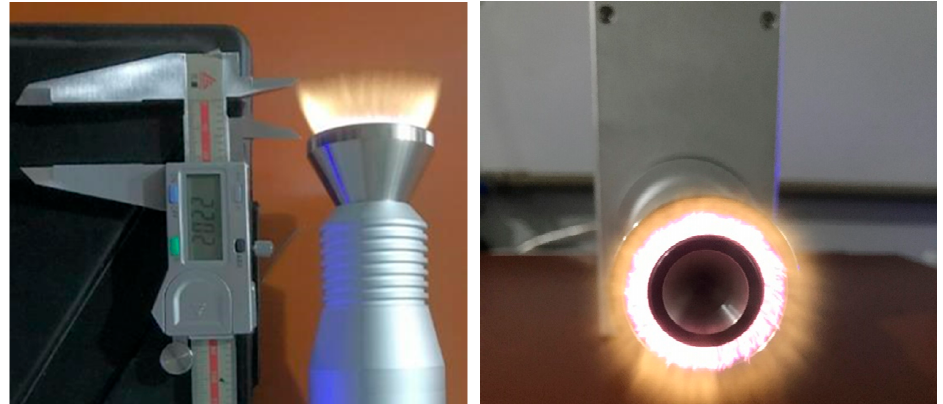
Figure 20. Discharge situation of plasma jet during operation.